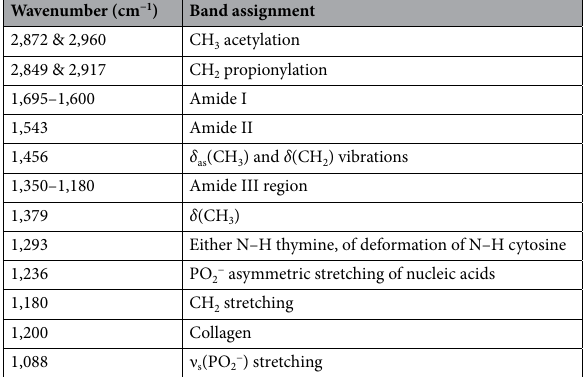
Table 1. Summary of key peaks and their corresponding band